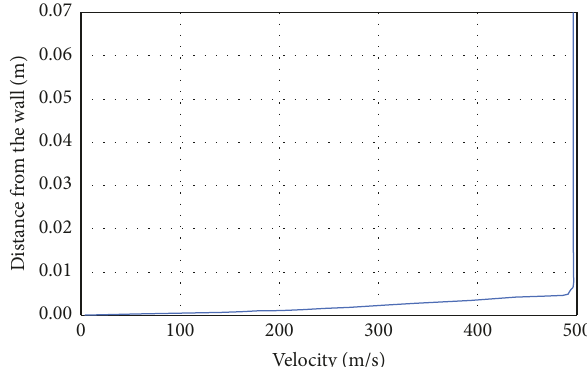
Figure 2: Boundary layer velocity profile used for the inlet boundary